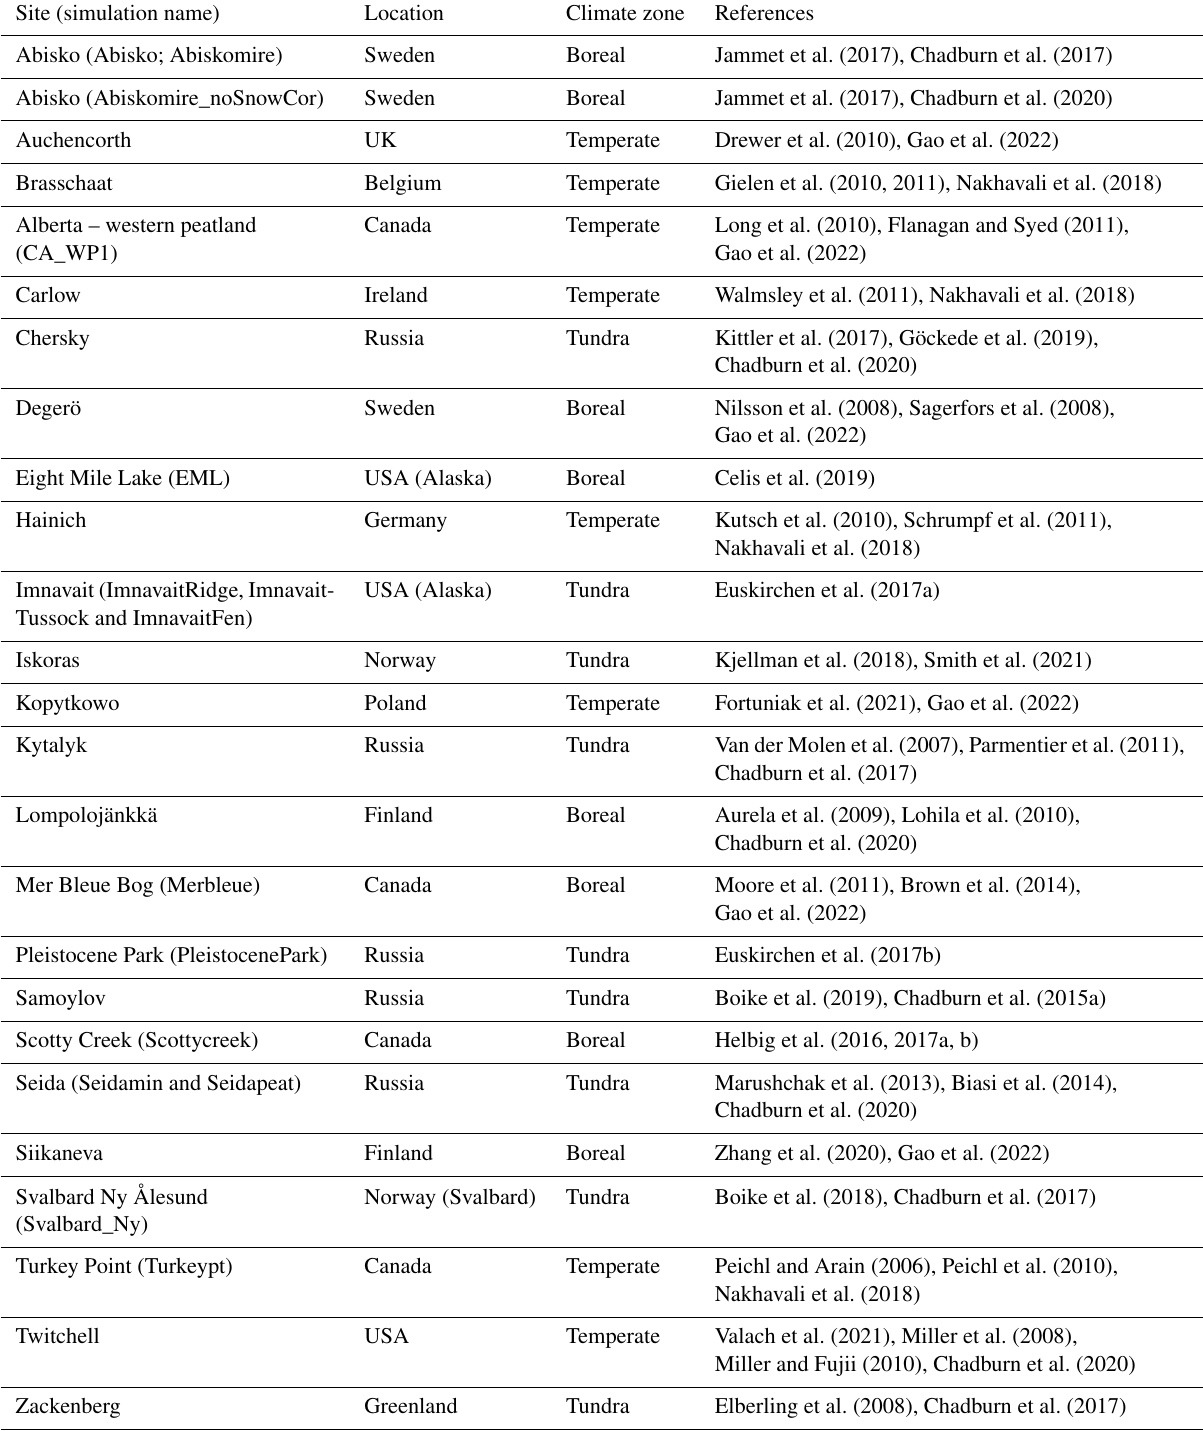
Table 1. Sites used in the suite of JULES simulations. References are both for site data and for simulations of these sites with